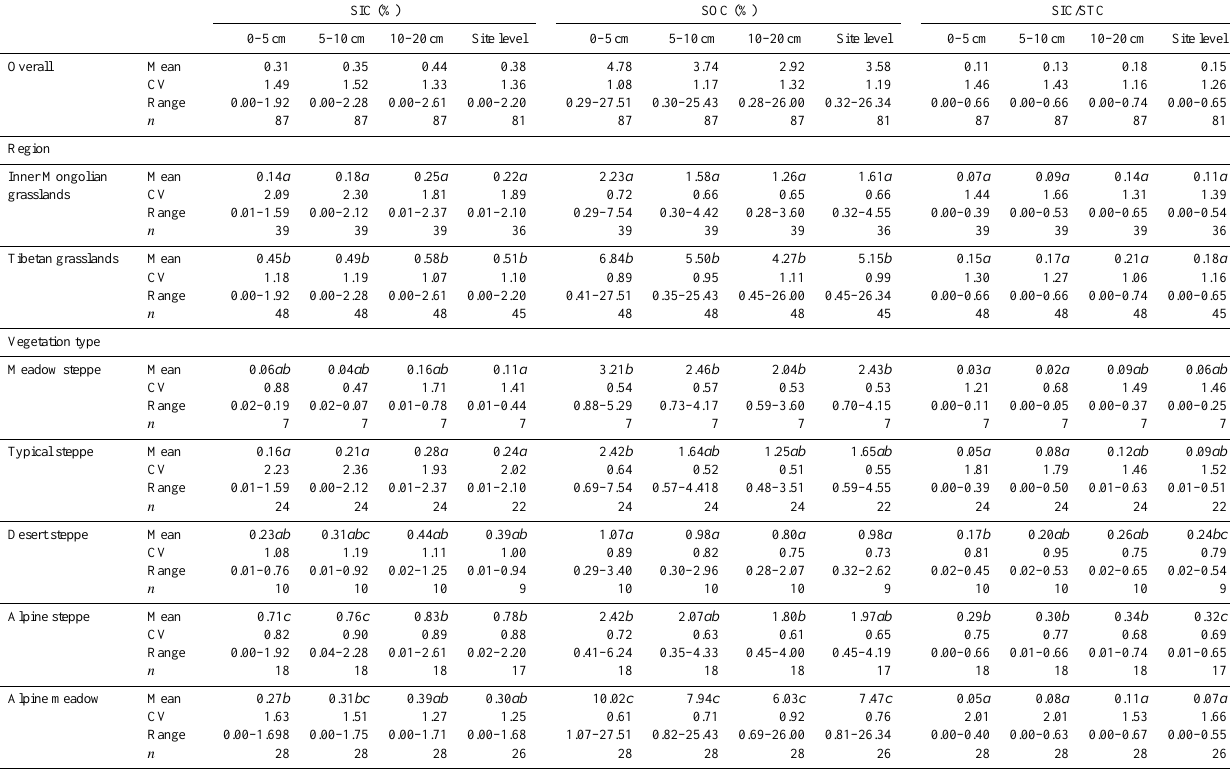
Table 3. Statistical description of soil inorganic carbon (SIC), soil organic carbon (SOC) content and SIC to soil total carbon ratio (SIC/STC) in each depth increment in different regions and vegetation types. Different letters indicate statistical significance at P < 0 . 05. CV=coefficient of